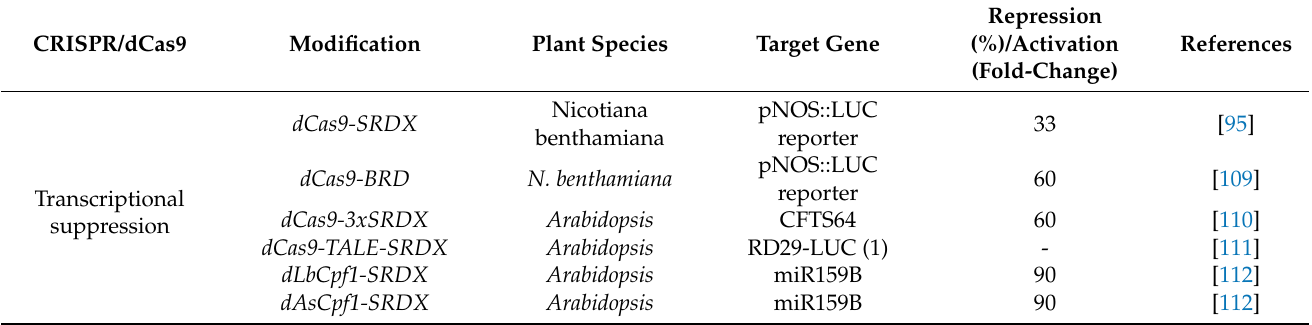
Table 1. Modification of CRISPR/dCas9 components for gene regulation in plant